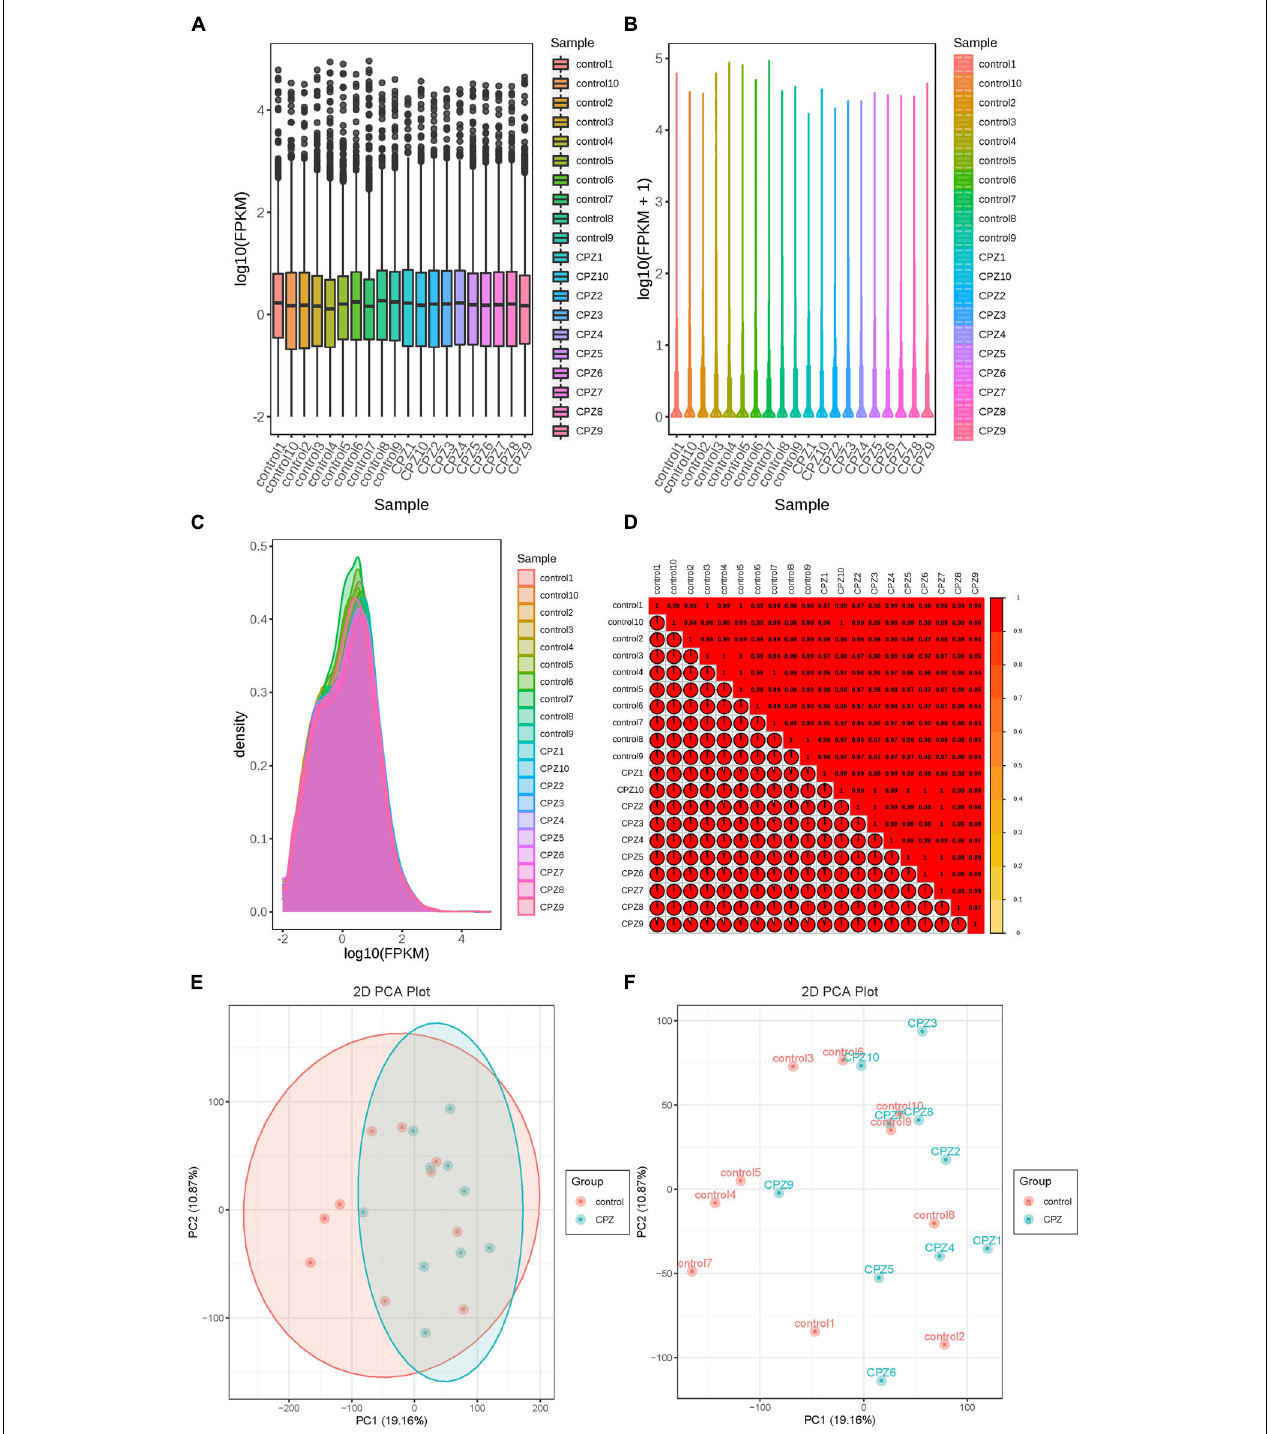
FIGURE 7 | (A) Box line diagram. (B) Violin plot. (C) Density distribution graph. (D) correlation heatmap of R 2 . (E,F) The plots of